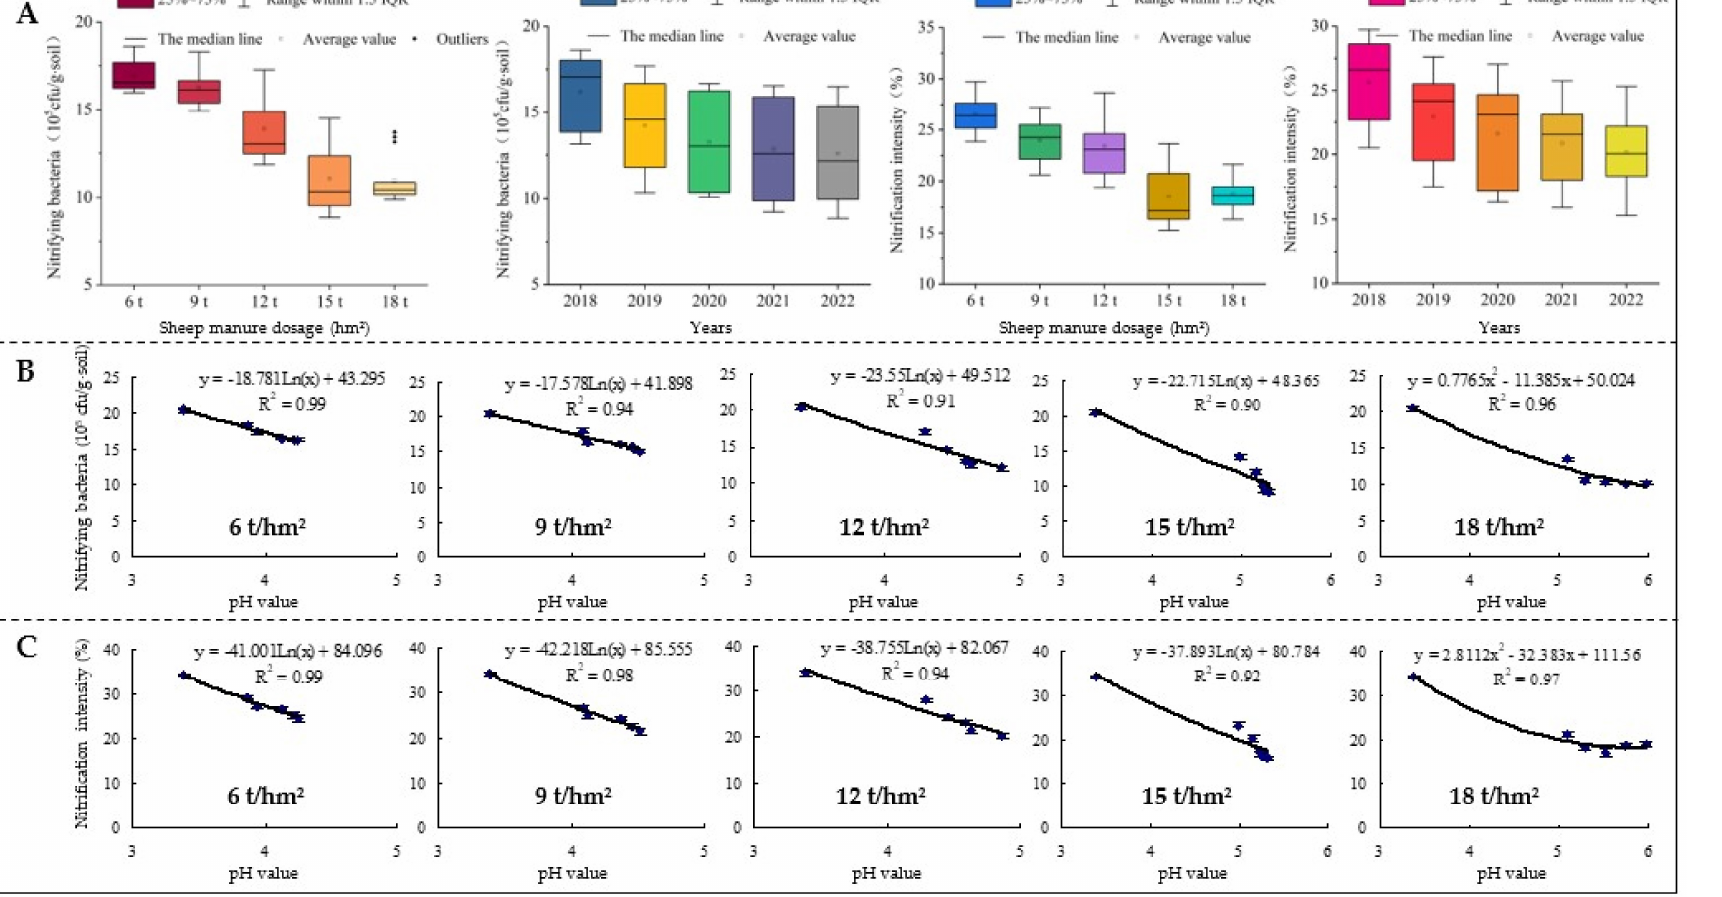
Figure 6. Effects of sheep manure fertilizer and pH value on the number of nitrifying bacteria and nitrification strength in tea plantation soil. ( A ) Effects of sheep manure fertilizer on the number of nitrifying bacteria and nitrification strength in tea plantation soil; ( B ) effect of pH value on the number of soil nitrifying bacteria in tea plantation after a continuous use of sheep manure fertilizer for 5 years; ( C ) effect of pH value on soil nitrification strength in tea plantation after a continuous use of sheep manure fertilizer for 5